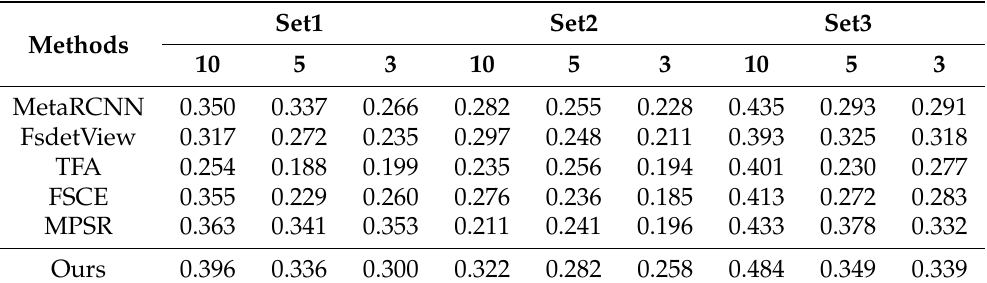
Table 3. Few-shot detection results for the novel classes on FUSAR-GEN for three different splits. We tabulate results for K = 3,5,10 shots under different